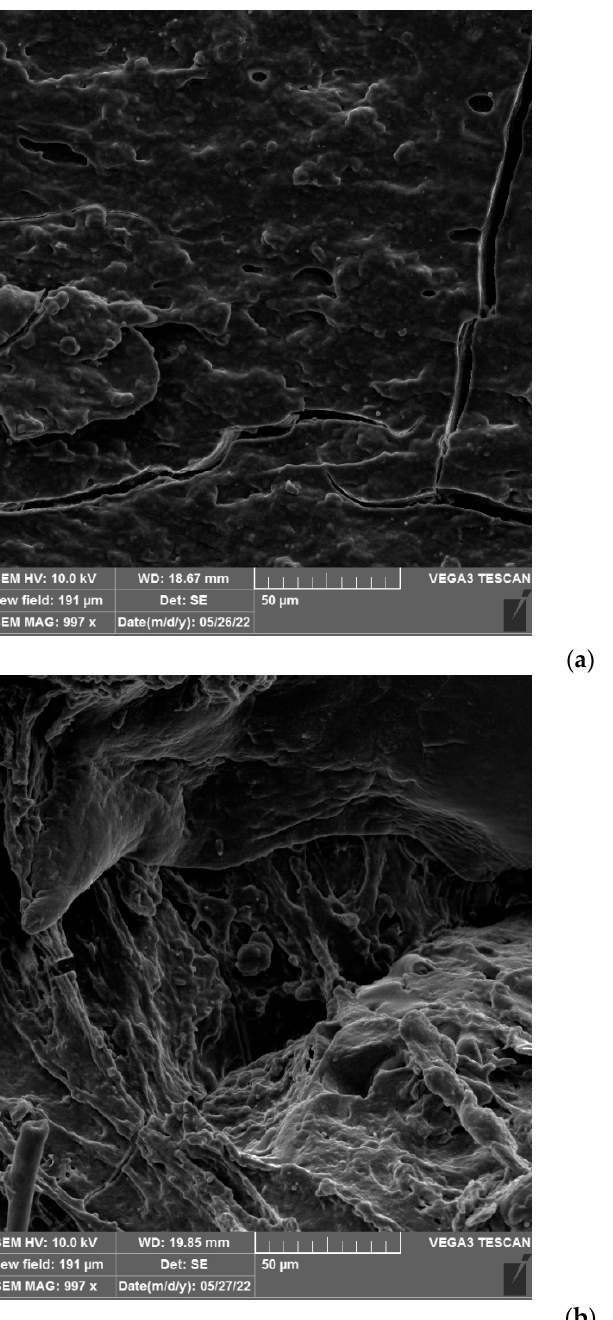
Figure 3. ( a ) The surface of the snack S2; ( b ) the cross-section of the snack S2. The SEM analysis demonstrated that the surface of the baked snacks (S3, S4) was smooth, dense and compact with swollen and gelatinized starch granules (Figures 4a,b and 5a,b). It was indicated that the starch granules were embedded in a protein matrix. Moreover, little cracks were visible on the surface of both samples. Additionally, the differences between the granules size were noticed meaning that their swelling was in- sufficient. It should be underlined (Figures 4b and 5b) that air bubbles (holes) were visi- ble on the cross-section of S3 and S4 snacks, confirming the expansion of the baked snacks. The structure of the S4 cross-section was less compact than the S3 structure. It should be mentioned that the S4 sample was similar to closed-cell foam in which gas formed little pockets surrounded by the protein network containing starch granules.